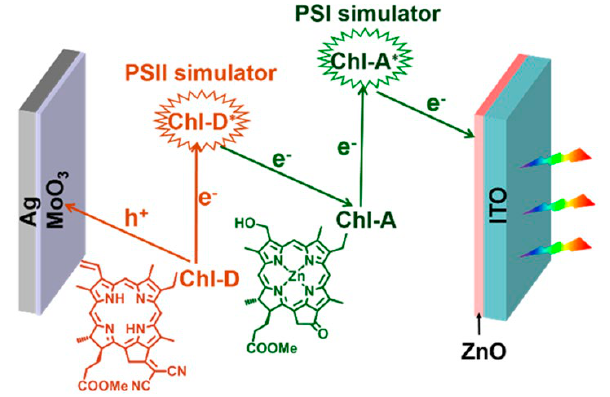
Figure 4. Schematic of indium tin oxide (ITO)/ZnO/Chl-a/(Chl- Ds)/MoO3/Ag devices mimicked the pathway of photoinduced electron transport from photosystem II (PSII) to photosystem I (PSI) in nature. Reprinted with permission from 18. Copyright (2018) American Chemical